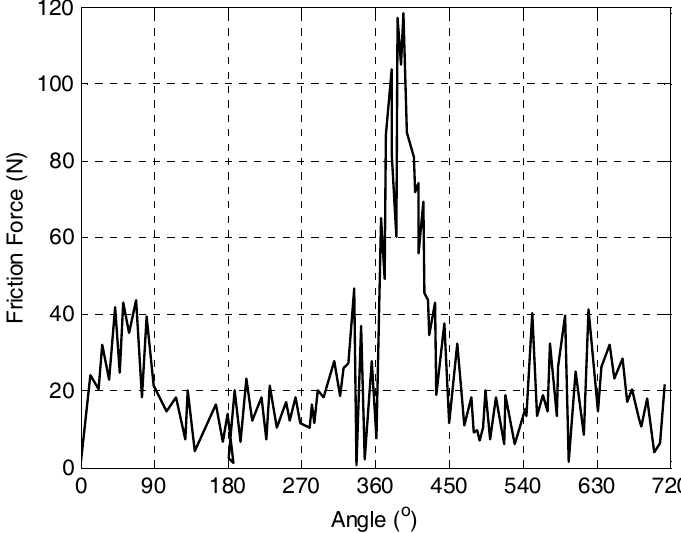
Figure 14. Measured friction in a single-cylinder engine [13] (major reviesd). Energies. 2017 , 7 , 2122